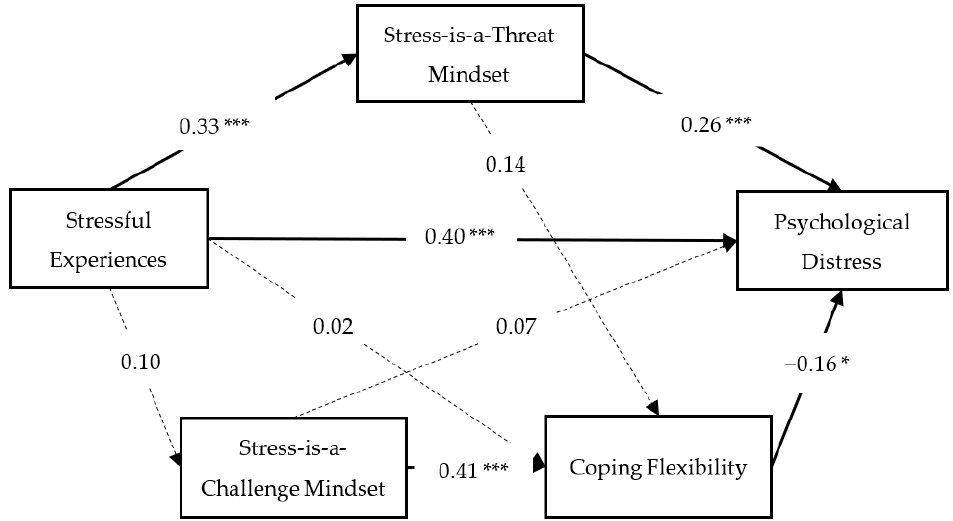
Figure 1. The dual-pathway model of stress coping. Standardized coefficients are presented. Non- significant paths are denoted using dashed lines. Gender (dummy coded as female: 1 = female, 0 = male) was controlled for in this model. *** p < 0.001; * p < 0.05.